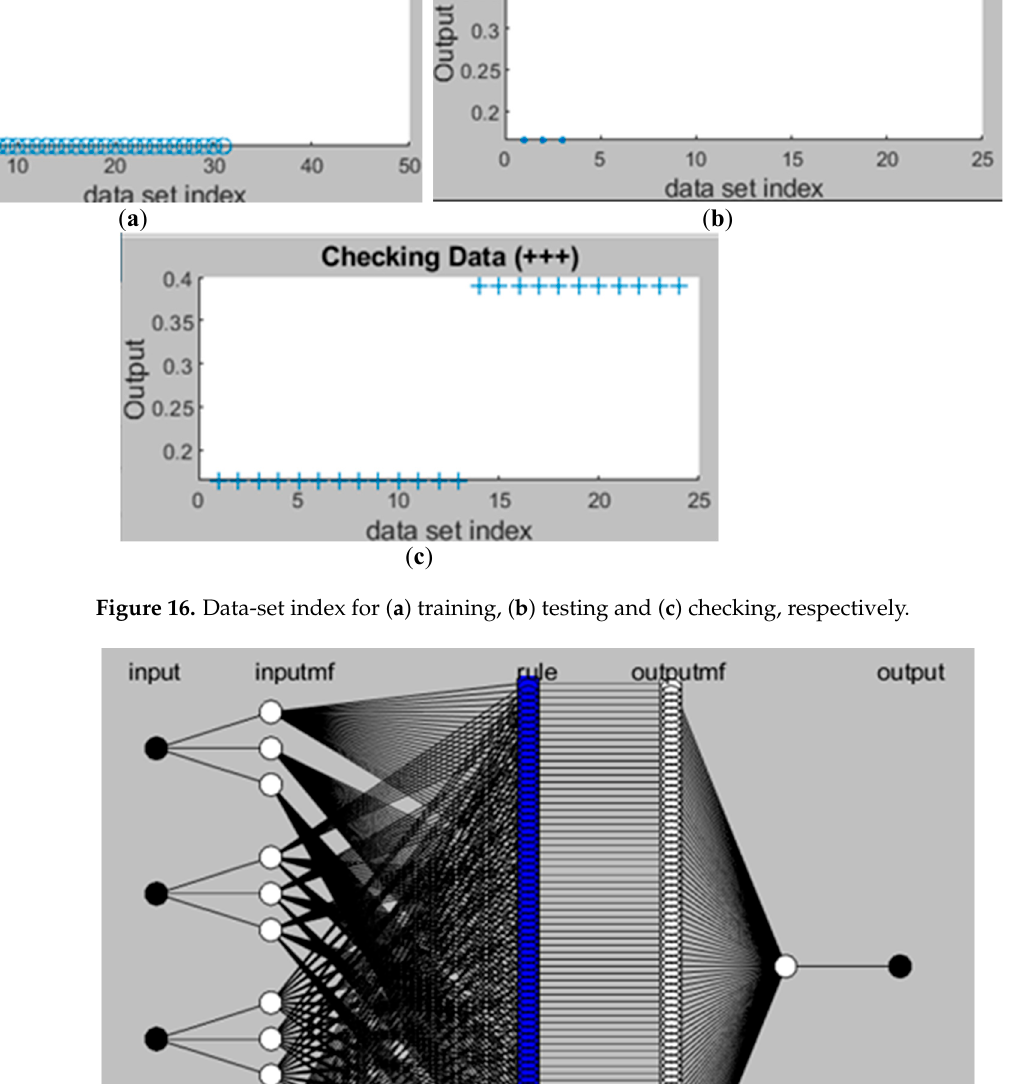
Figure 16. Data-set index for ( a ) training, ( b ) testing and ( c ) checking, respectively.